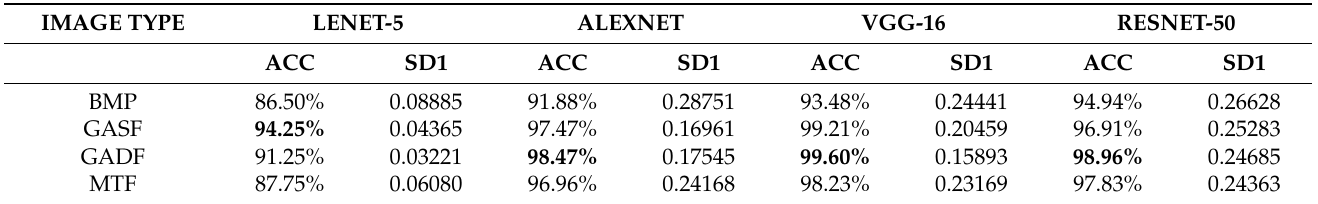
Figure 8. Training curve results for four different types of images using LeNet-5, AlexNet, VGG-16 and ResNet-50, where the images on the ( a , c , e , g ) show the test accuracy curves and the images on the ( b , d , f , h ) show the corresponding loss curves. Table 1. The test accuracies (ACC) and curve standard deviations (SD1) for four different types of images using four different neural networks. The values marked in bold are the highest ACC value in each